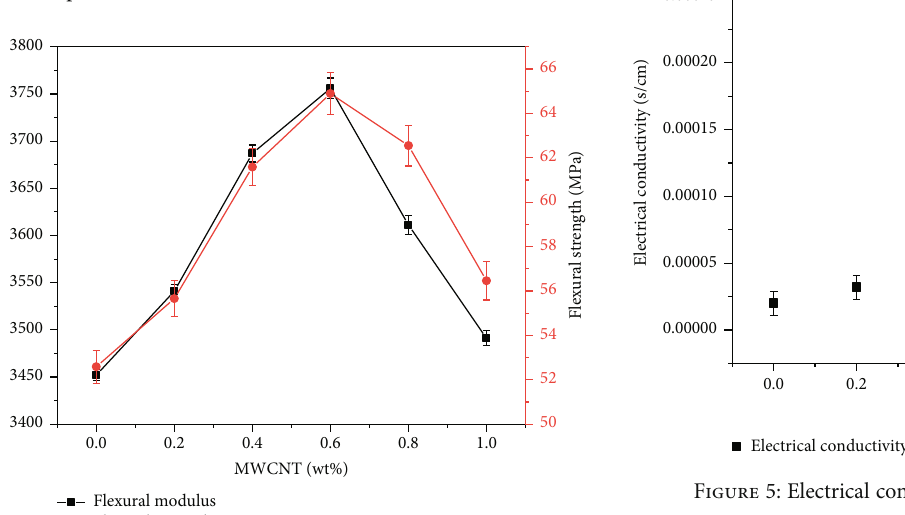
Figure 2: Flexural load vs. displacement of MWCNT nanocomposites.